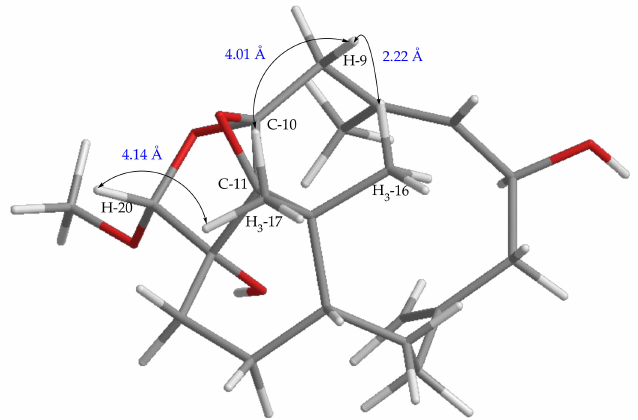
Figure 6. Selected NOE correlations of compound 8 .